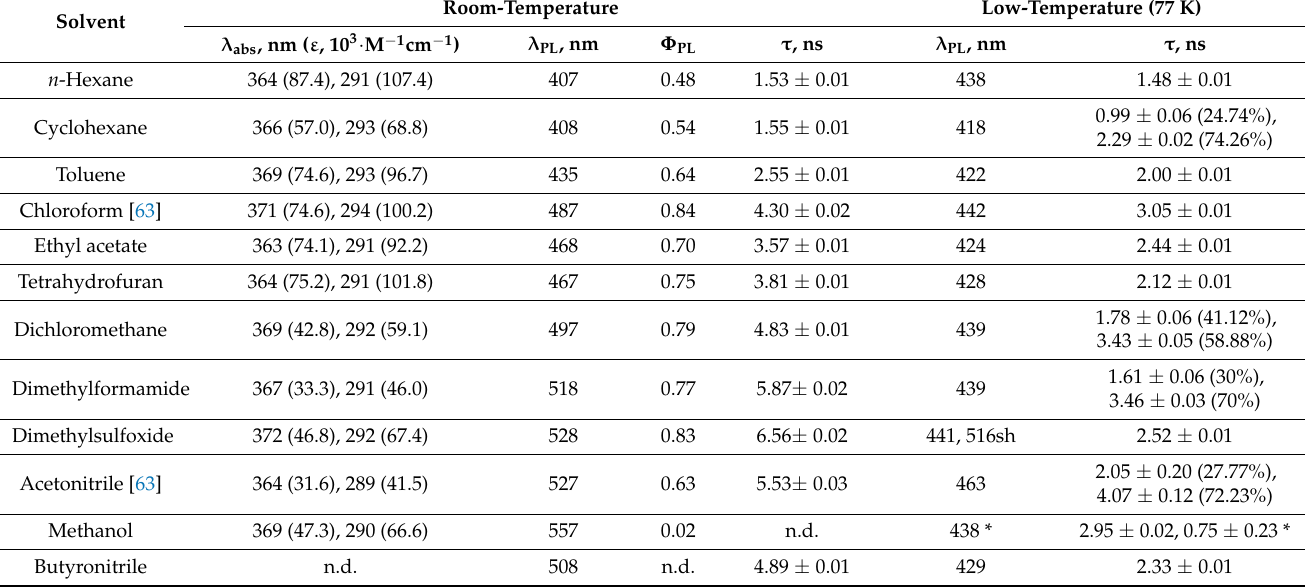
Table 1. Spectral properties of tBuTPAterpy